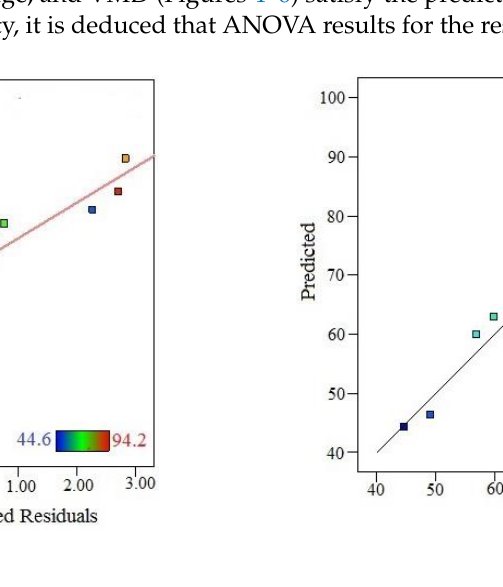
Figure 4. ( a ) Normal % probability plot of residuals for droplet density; ( b ) plot of actual vs. predicted response for droplet density.